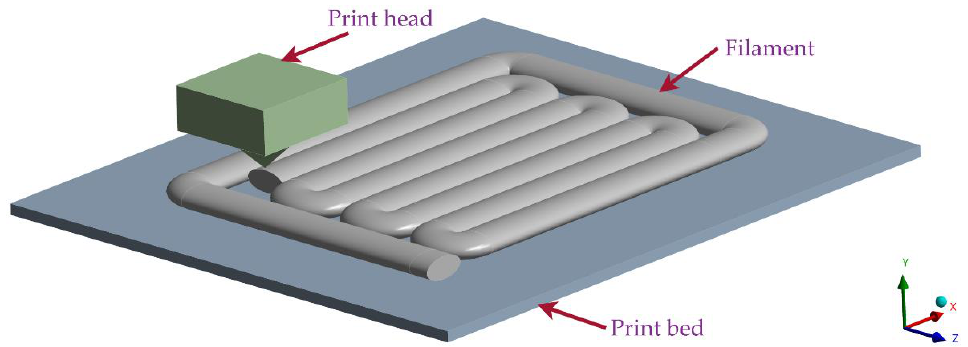
Figure 1. Fundamental scheme of fused filament fabrication printer. The controlled deposition of material into structure allows printing of various infill pattern types.